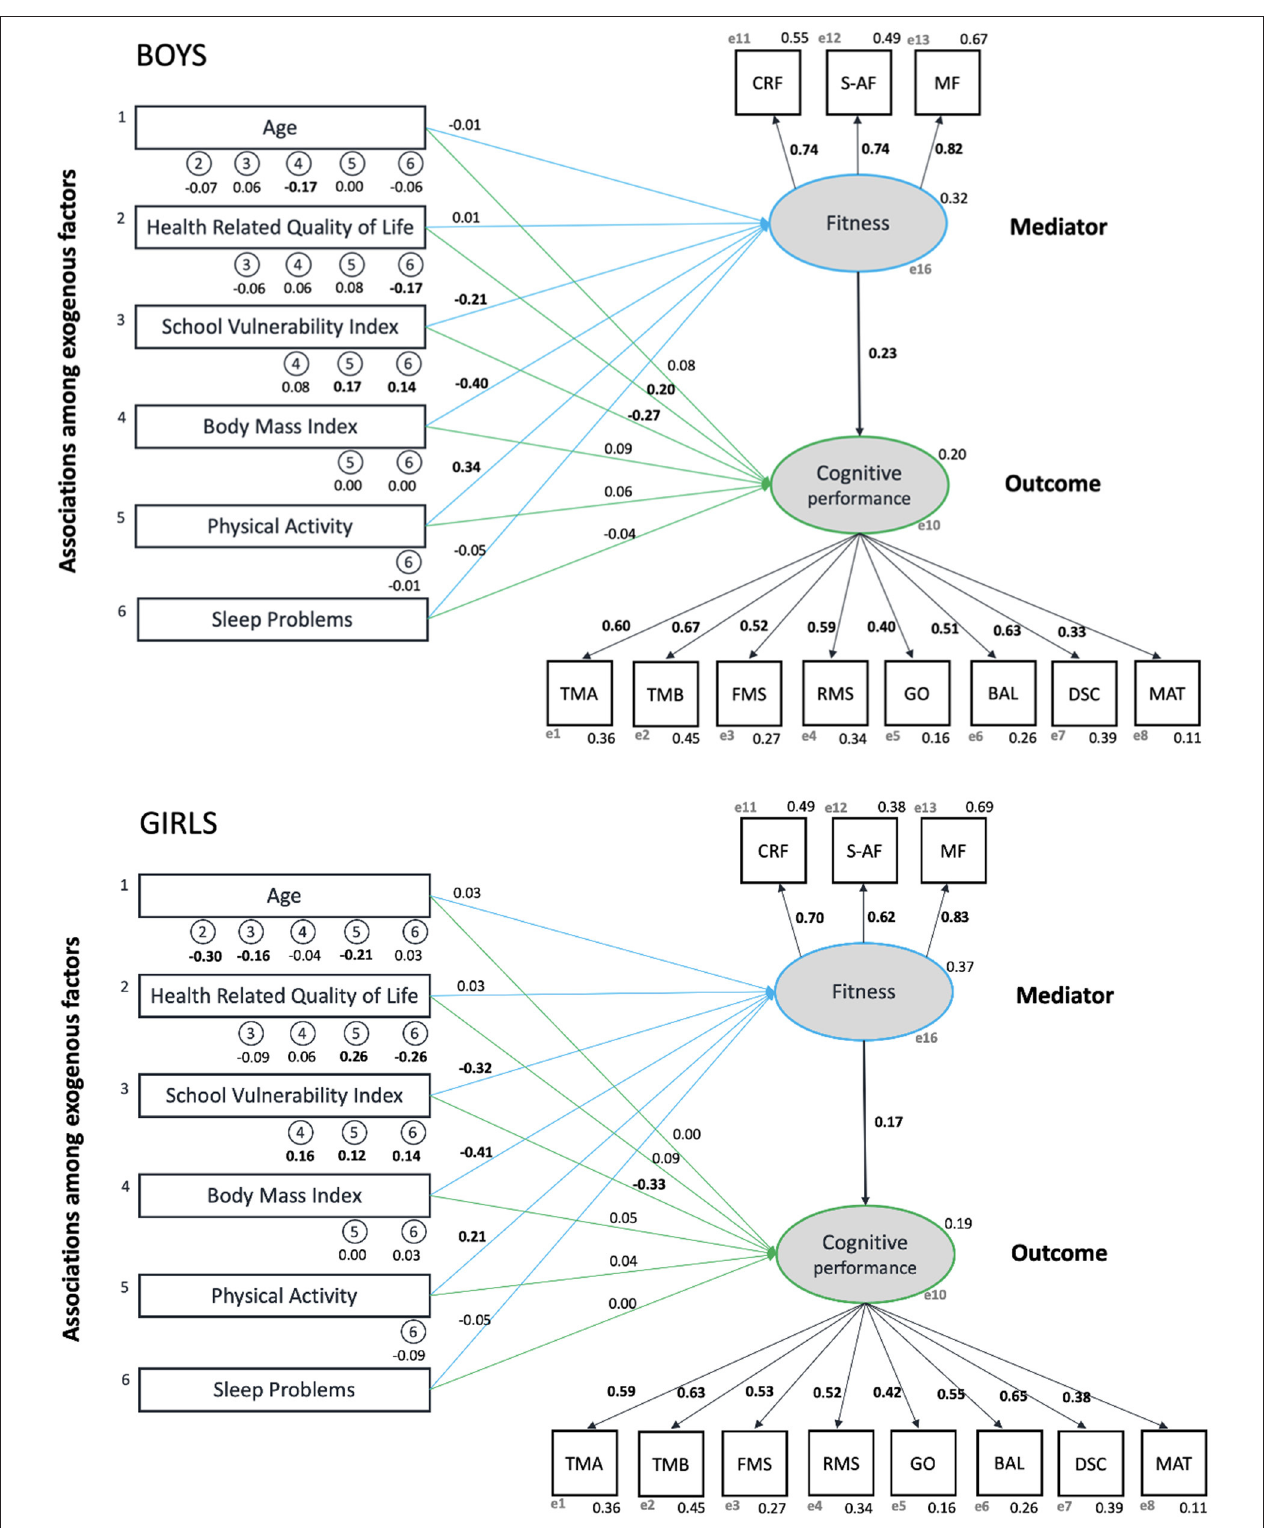
FIGURE 2 | Structural equation model showing the association among different factors and the mediation role of fitness with cognitive performance in boys (superior figure) and girls (inferior figure). All values are Standardised beta coefficients. CRF, cardiorespiratory fitness; S-AF, Speed-Agility Fitness; MF, Muscular Fitness;